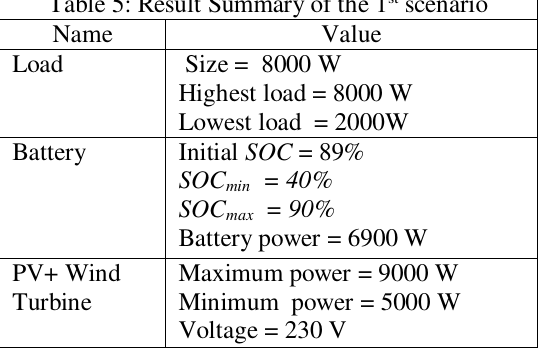
Table 5: Result Summary of the 1 st